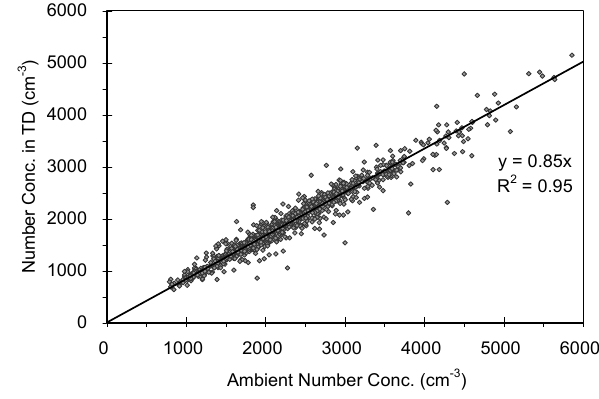
Figure 3. Number concentrations in the thermodenuder (TD) versus ambient aerosol number Fig. 3. Number concentrations in the thermodenuder (TD) vs. am- concentrations for FAME-2008. The line is a linear fit of y = 0.85x. Each data point is the bient aerosol number concentrations for FAME-2008. The line is a average of 24 min. linear fit of y = 0 . 85 x . Each data point is the average of